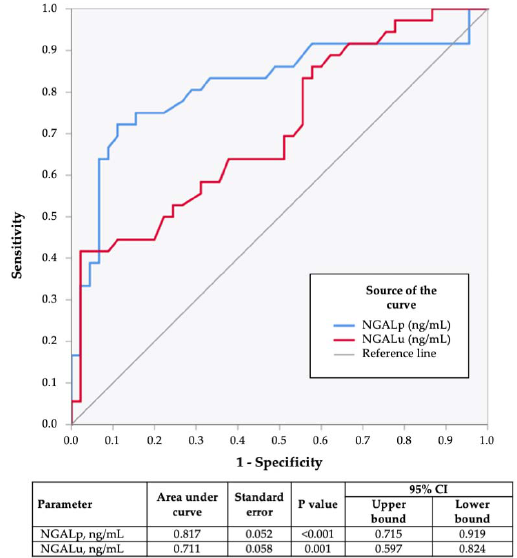
Figure 2. Receiver operating characteristic (ROC) analysis showing the performance of NGALp and NGALu for the detection of DKD.